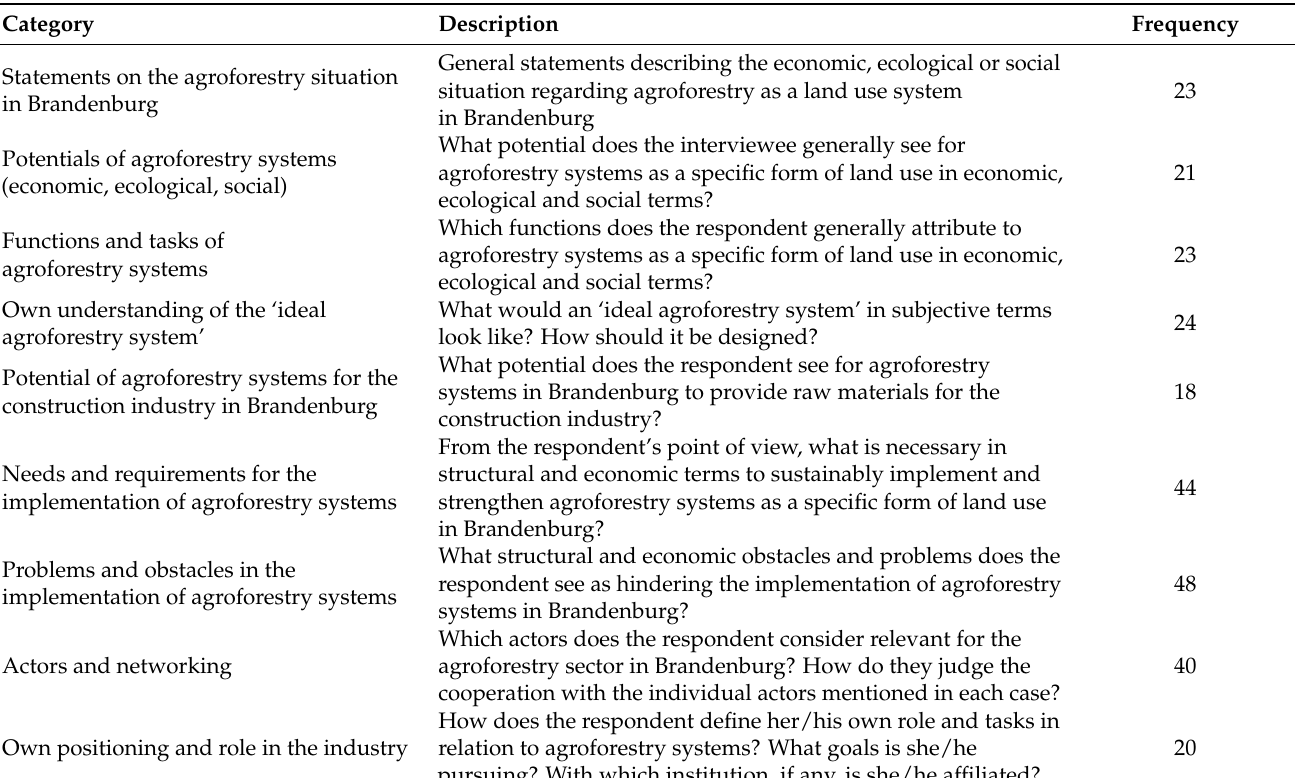
Table 1. Inductively formed category system (left) and description